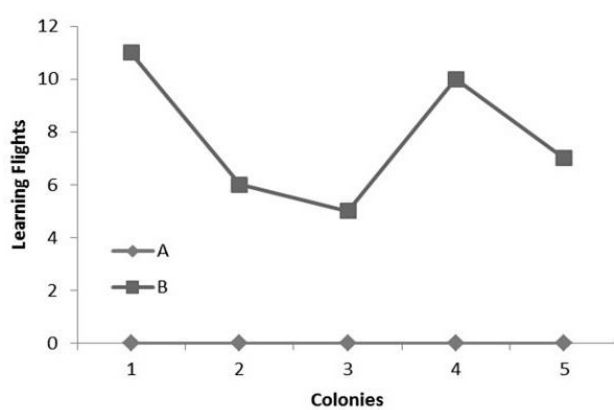
Fig 4 . Number of “learning flights” performed by workers of the five colonies of Polybia paulista , during the experiments with the Helmholtz coils. A: normal geomagnetic field. B: altered magnetic